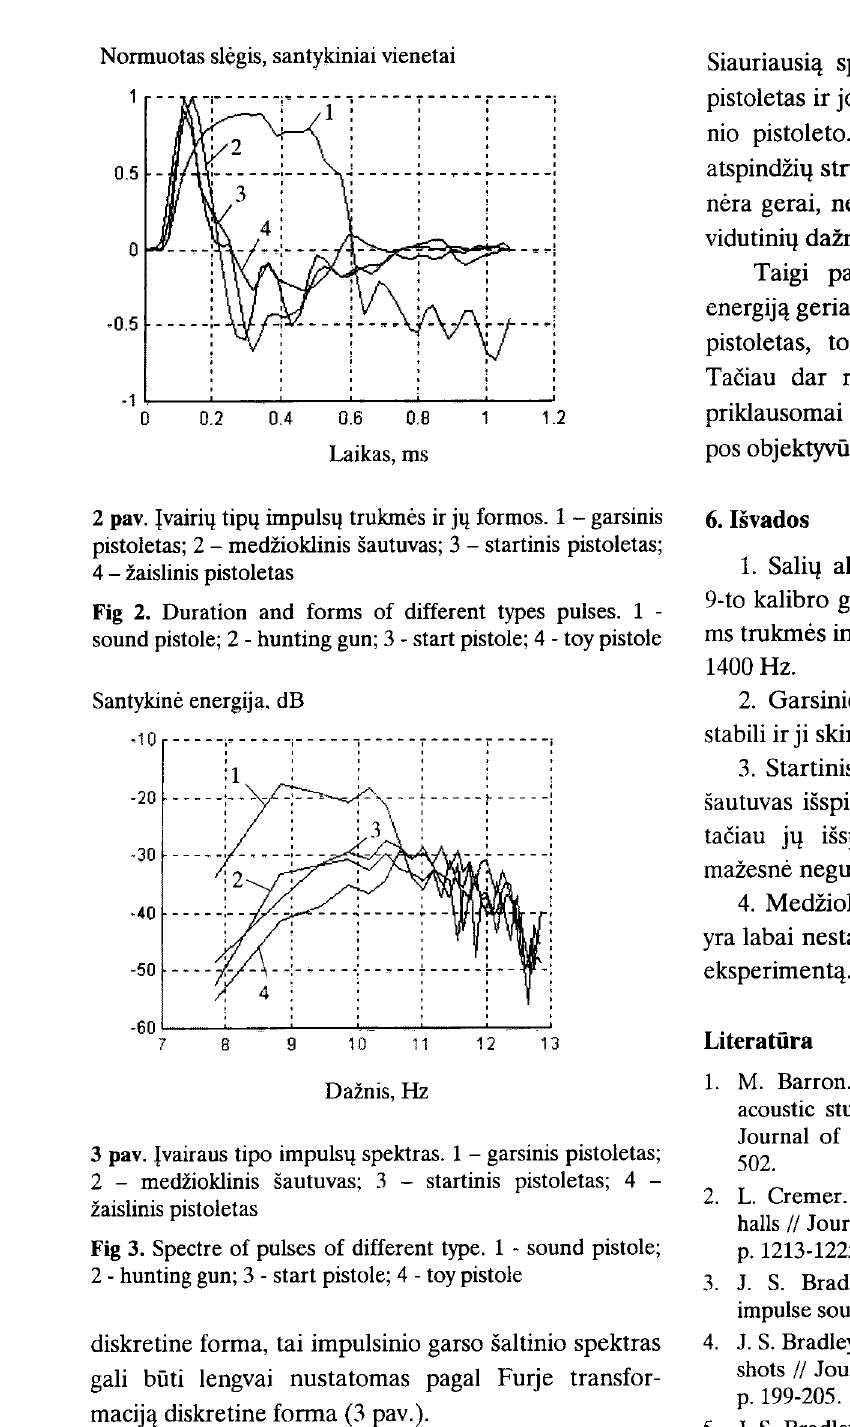
Fig 3. Spectre of pulses of different type. 1 - sound pistole; 2 - hunting gun; 3 - start pistole; 4 - toy pistole diskretine forma, tai impulsinio garso saltinio spektras gali biiti lengvai nustatomas pagal Furje transfor macijq diskretine forma (3